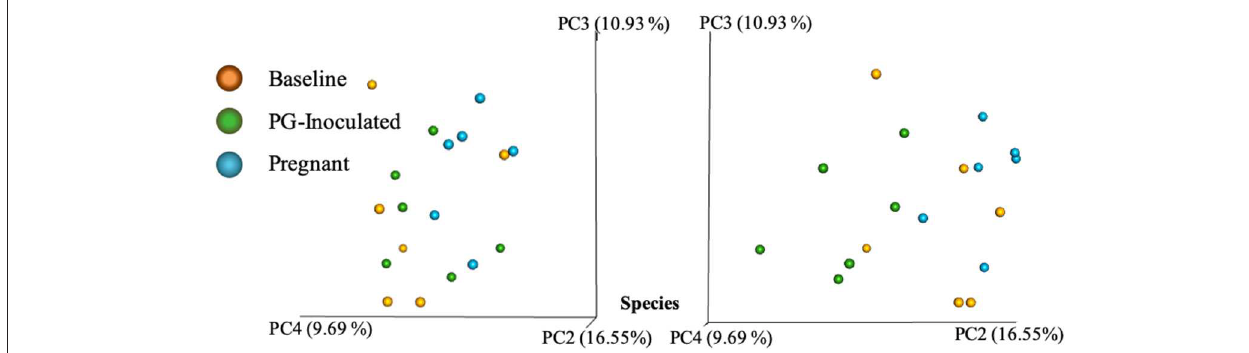
FIGURE 6 | Bray Curtis PCoA plot of beta diversity measures of dissimilarity shows that at the genus level, the baseline, PG-inoculated, and pregnant groups clustered within their groups along PC3 at the (A) genus level and (B) family level.